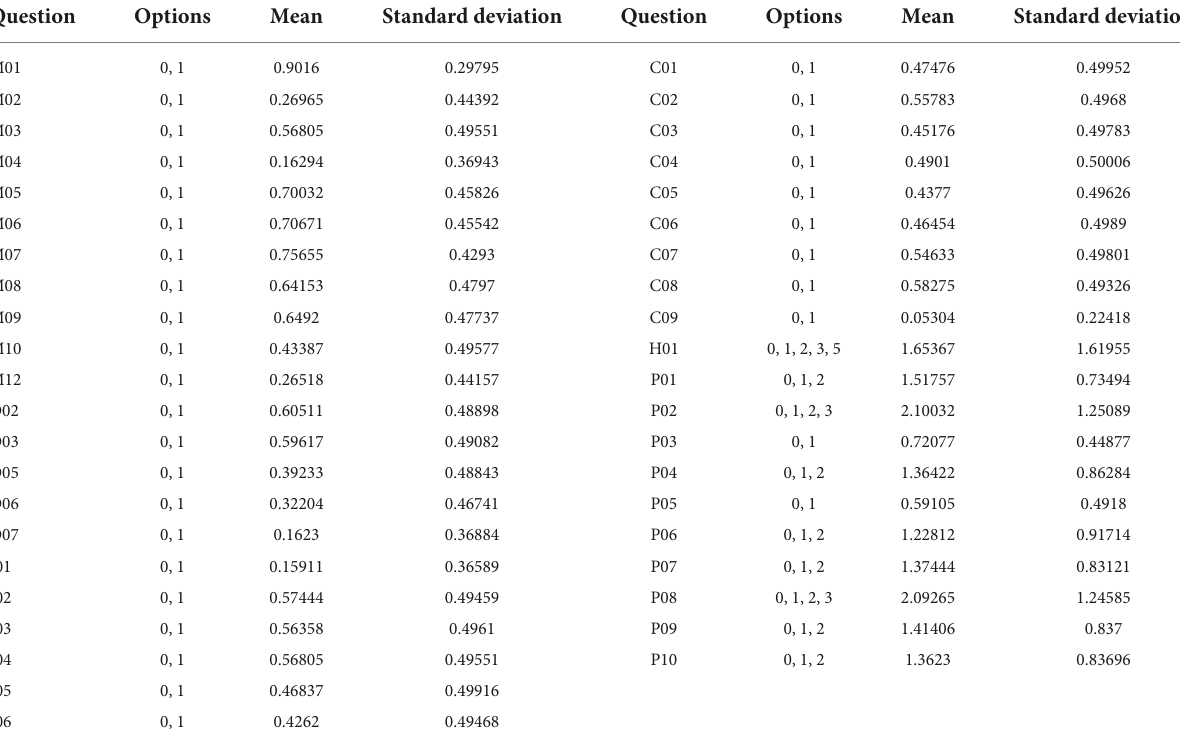
TABLE 5 Average and standard deviation of the problem.